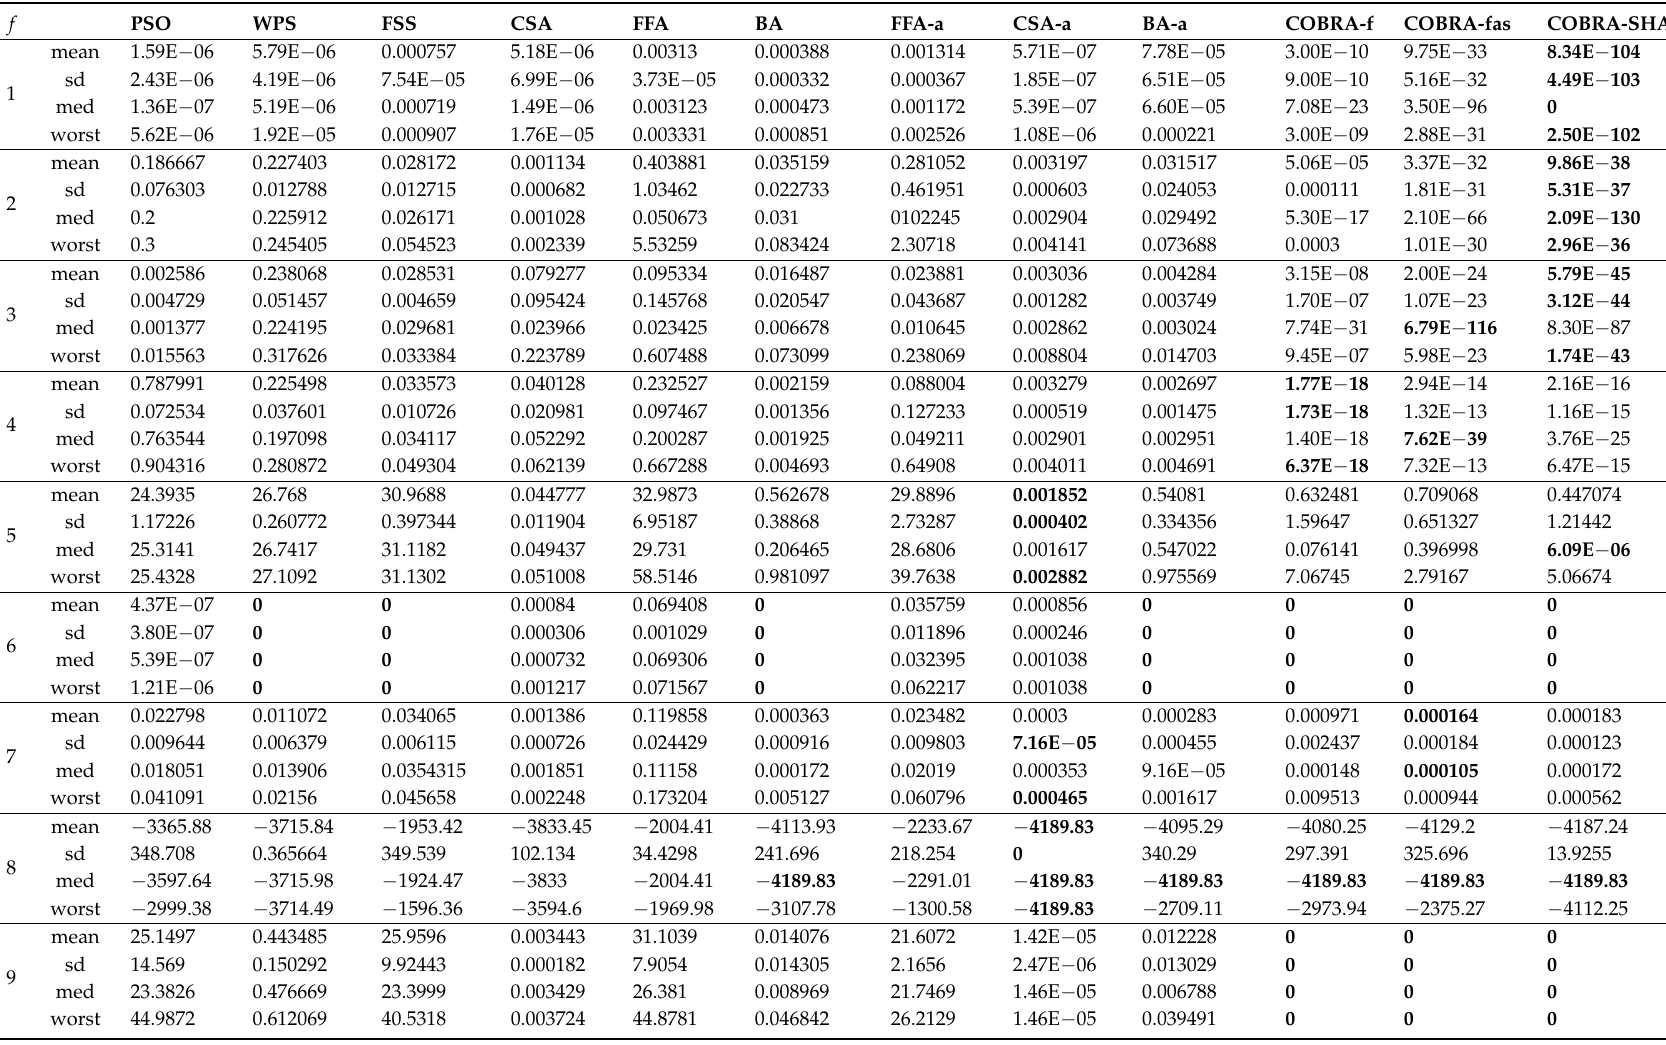
Table 2. Minimization results of 23 benchmark functions from SET-1 for compared